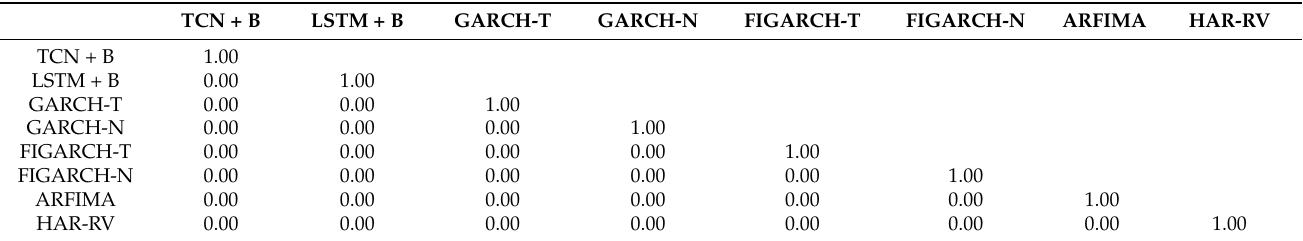
Table 7. Kolmogorov–Smirnov (KS) test results of different models.